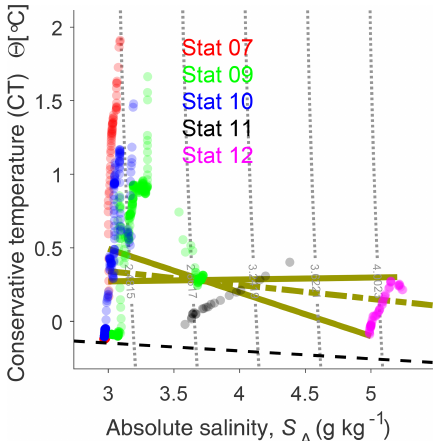
Figure 8. TS diagram for stations 7, 9, 10, 11, and 12 (Fig. 3). Gray dotted lines show the density. Greenish solid and dash-dotted lines show mixing lines for station 9 bottom water from Bothnian Bay and Bothnian Sea surface water, and from Bothnian Bay water and brine, respectively. Brine is outside the figure with SA of 15gkg − 1 and CT of − 0 . 79 ◦ C. Only data points with oxygen concentration close to saturation are considered. For station 12, data points are restricted to a depth shallower than 20m. The dashed black line is the freezing temperature. Stronger opacity of the data points refers to a higher number of data.